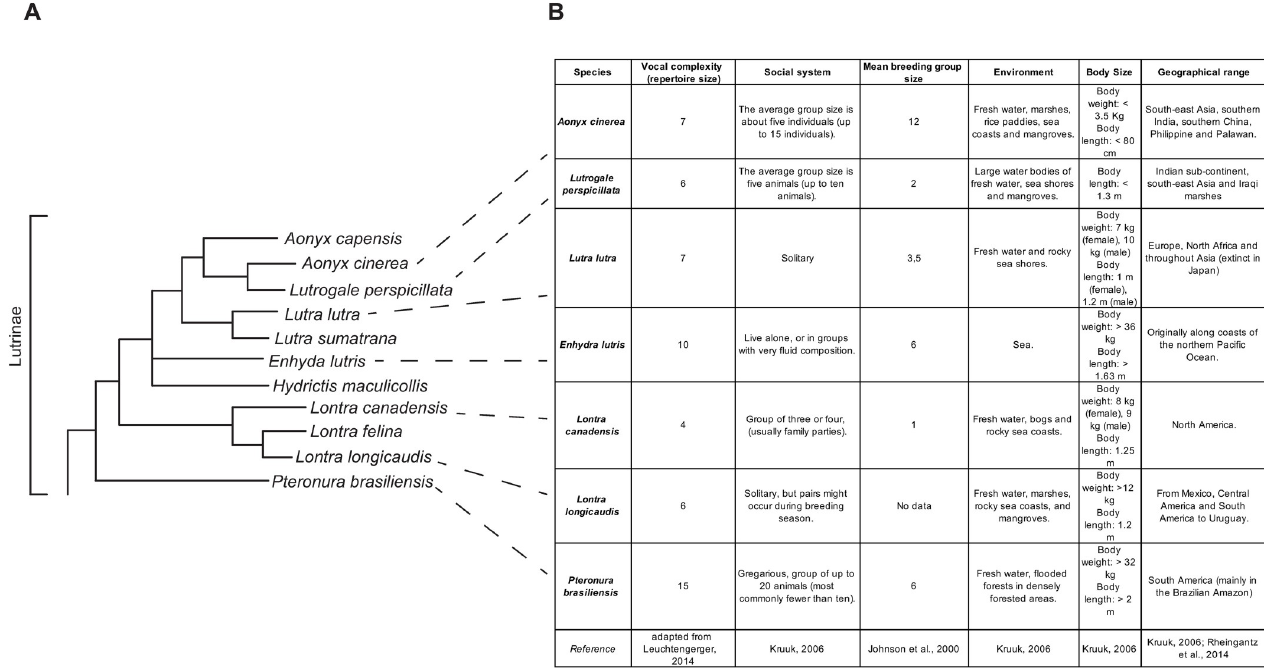
Fig 5. General information about otter species. (A) Phylogenetic tree (adapted from Koepfli et al. 2008 [10]); (B) Overview of otter species whose vocal repertoires have been studied.